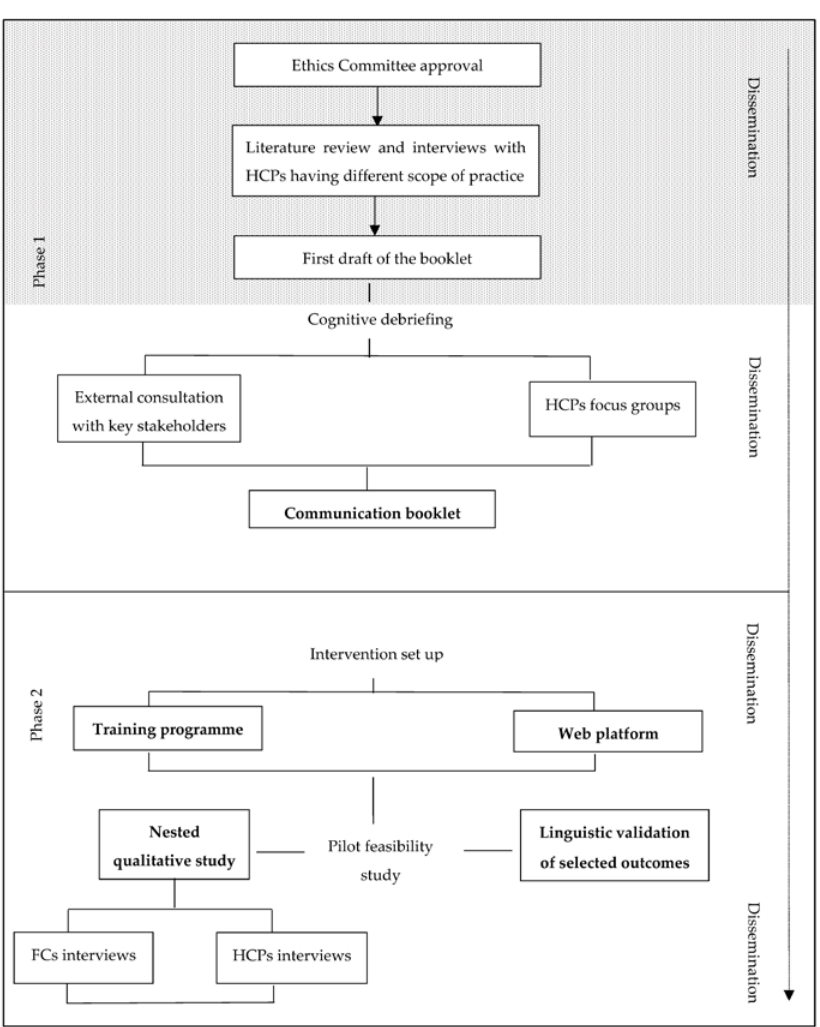
Figure 1. Flow chart of the Teach-to-Communicate project. Note. The dot area identifies the ad- vancement status at the time of manuscript submission. Abbreviations. FCs, Family carers; HCPs, Healthcare